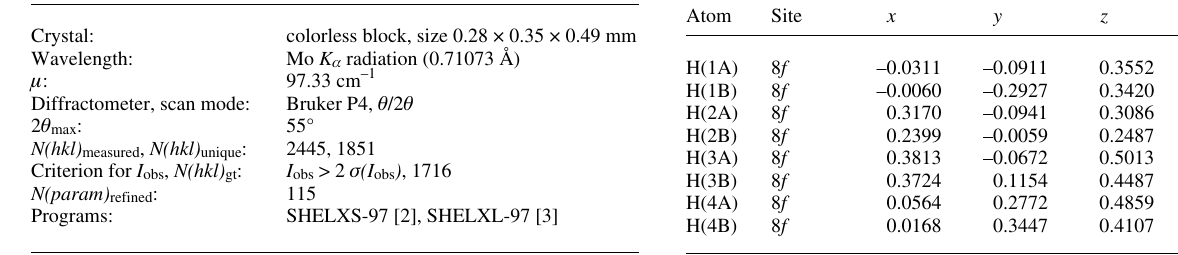
Table 5. Atomic coordinates and displacement parameters (in Å 2 ) .